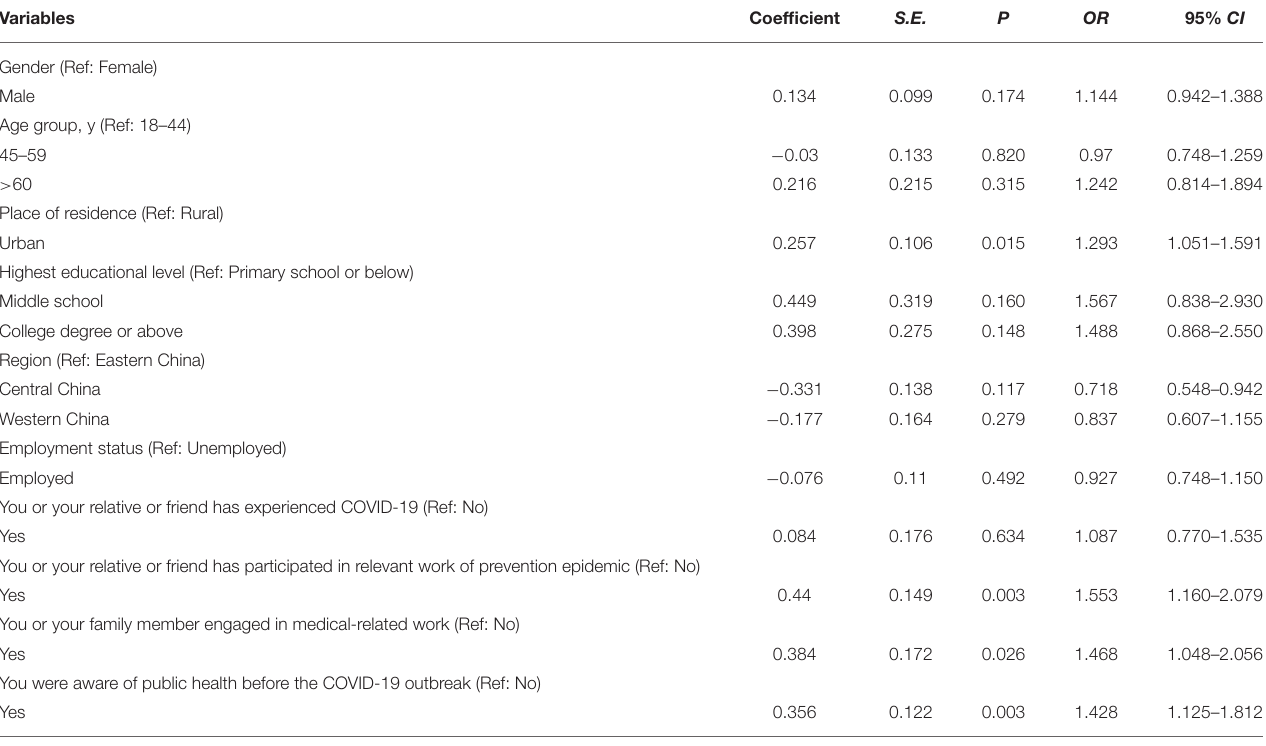
TABLE 3 | Mixed-Effect logistic regression analysis on the influencing factors of residents’ attitudes of developing public health professionals. Variables Coefficient